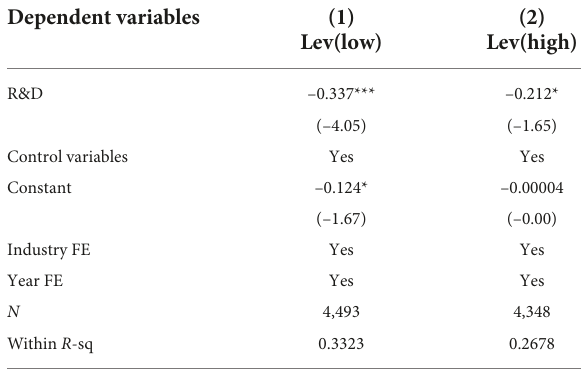
TABLE 12 Impact analysis of different leverage